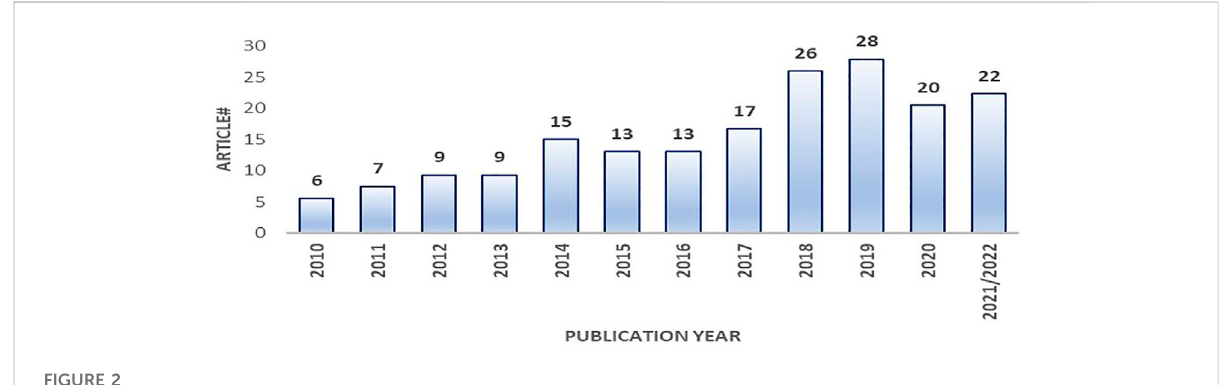
FIGURE 2 A number of publications Vs. published